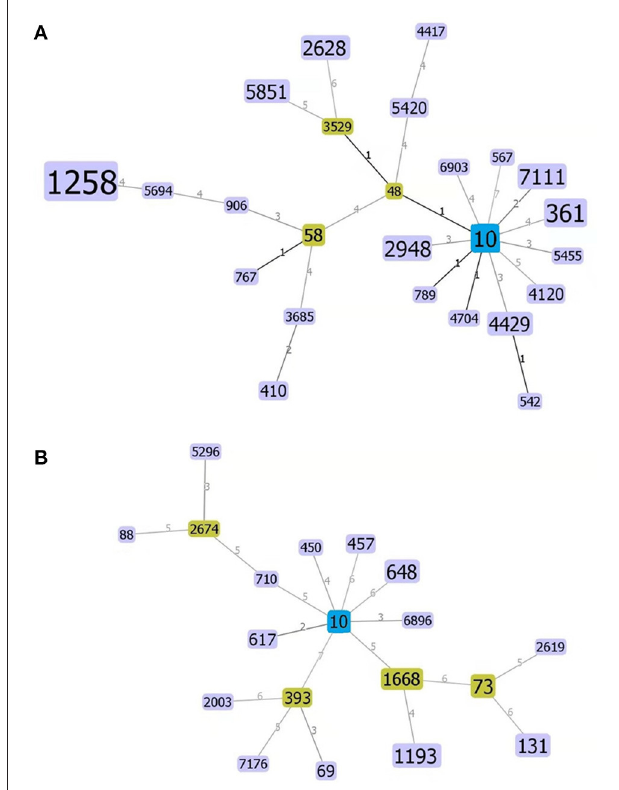
FIGURE 4 | Homogeneity group analysis of swine- (A) and human-derived E. coli (B) using the eBRUSTv3 software. ST10 is a common ancestor (Founder), which is blue colored and subgroup yellow colored, and a unit point variant [single-locus variants (SLVs)], which are purple colored that are closer to their kinship. The areas of each of the circles indicate the prevalence of the sequence types (STs) in the input data. Lines between the circles indicate the relationships between various